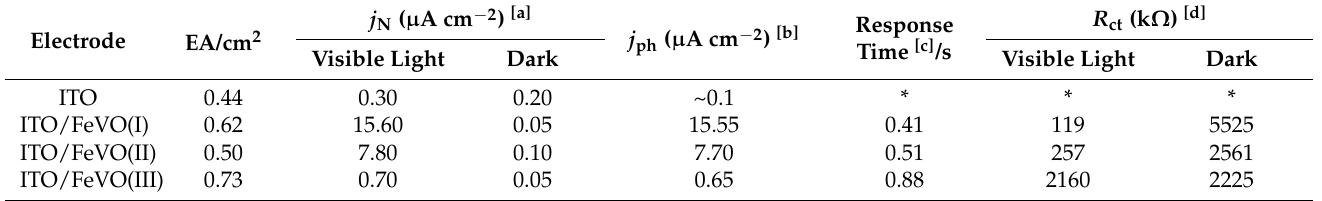
Table 1. Photoelectrochemical parameters of ITO/FeVO electrodes obtained by the SILAR